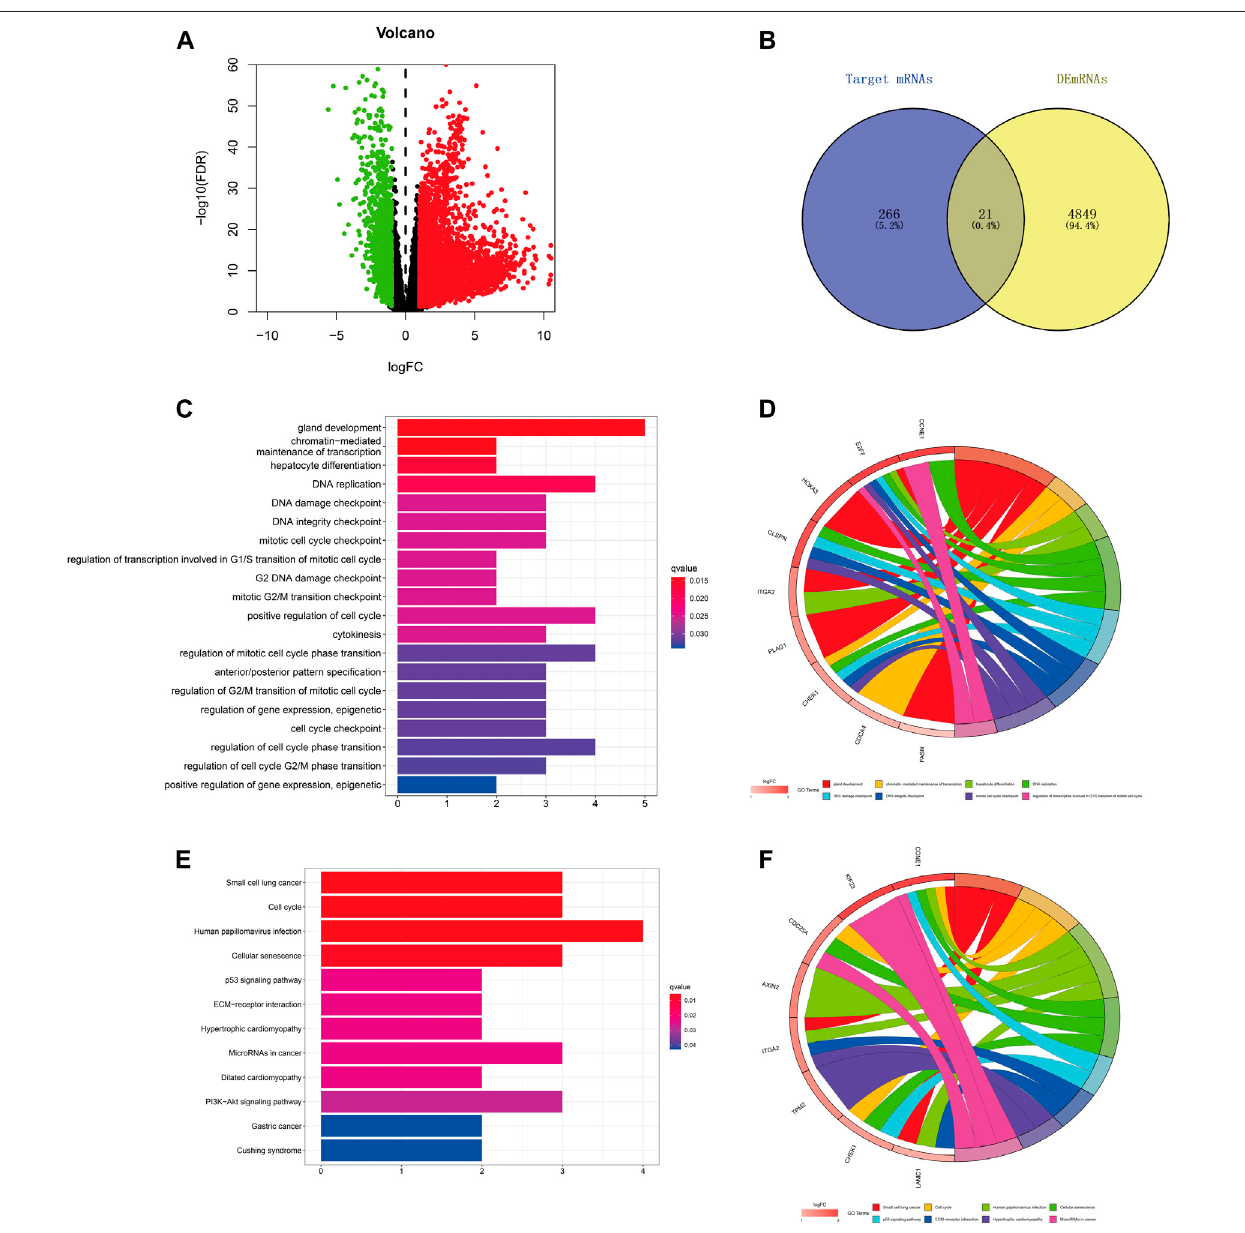
FIGURE 6 | Prediction and analysis of target genes of hsa-miR-195 – 5p in LIHC. (A) The volcano plot of differentially expressed mRNAs in LIHC from TCGA (adjusted p < 0.05 and |logFoldChange| > 1). (B) Venn diagram analysis of the target mRNAs of hsa-miR-195 – 5p and upregulated DEmRNAs. (C – F) GO and KEGG pathway analyses of the 21